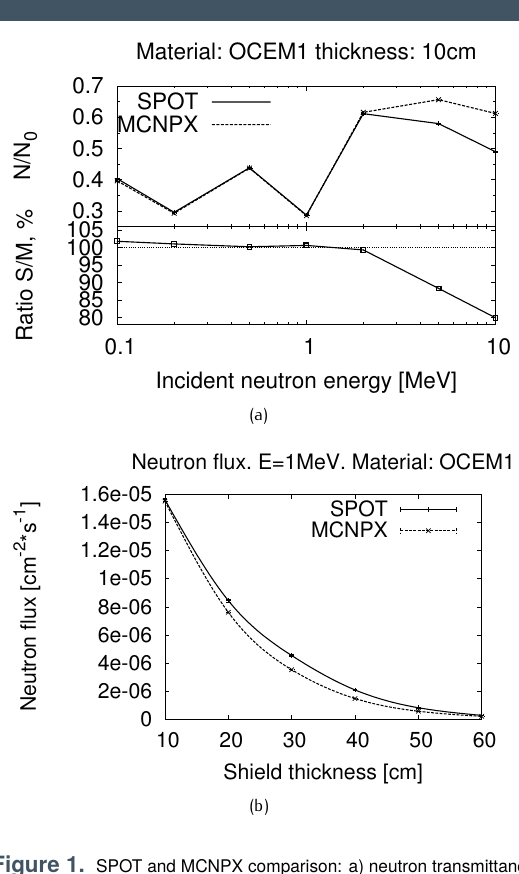
Figure 1. SPOT and MCNPX comparison: a) neutron transmittance vs. incident neutron energy for 10 cm concrete thickness, b) neutron flux for 1.0 MeV incident neutron energy trans- mittance vs. concrete